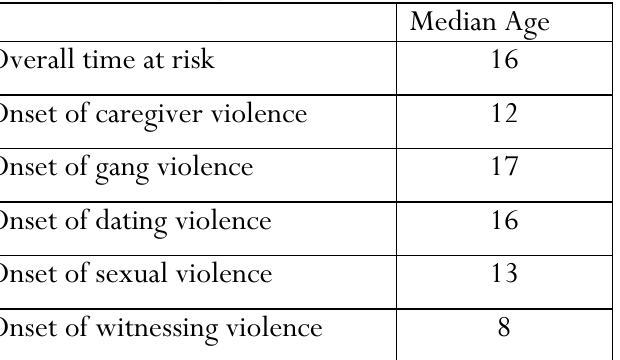
Table 5: Median Exposure and Survival Time to